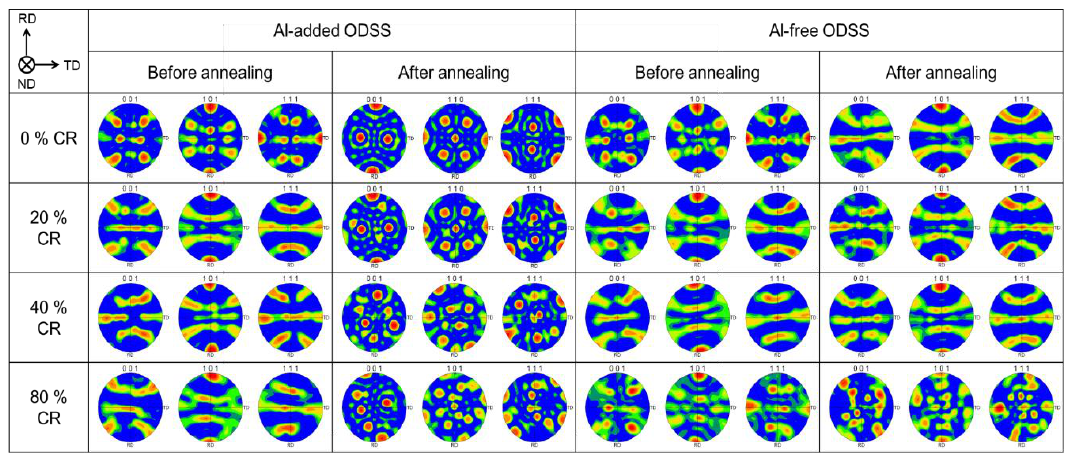
Figure 7. Pole figures of EBSD deformation texture before and after annealing at each temperature, are the same as the conditions shown in Figure 6. Grain morphology of Al-added and free 15Cr-ODS ferritic steels after annealing at each temperature. Cold rolling was performed before isothermal annealing.